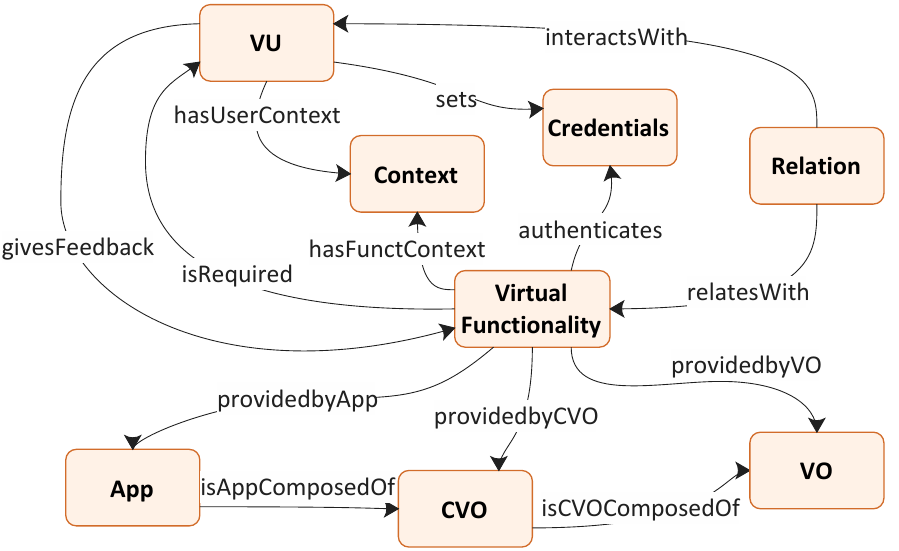
Figure 3. Semantic description of the VU profile